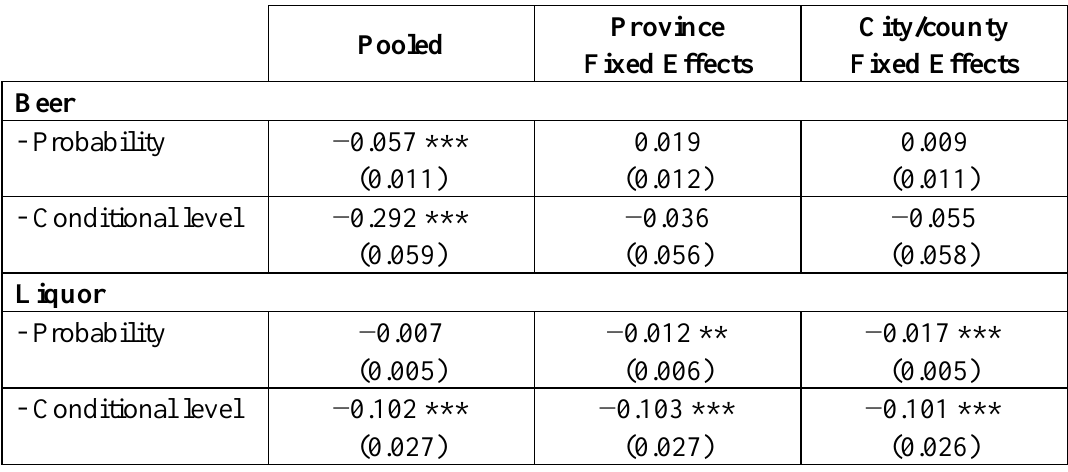
Table 2. Price elasticities of alcohol demand in China, overall